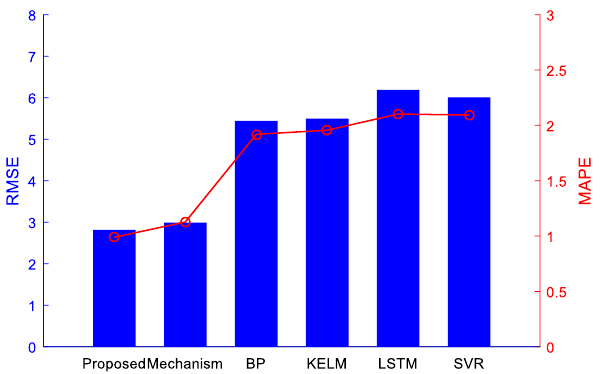
Figure 9. Results for different prediction models, including RMSE and MAPE values when the data fluctuate greatly.